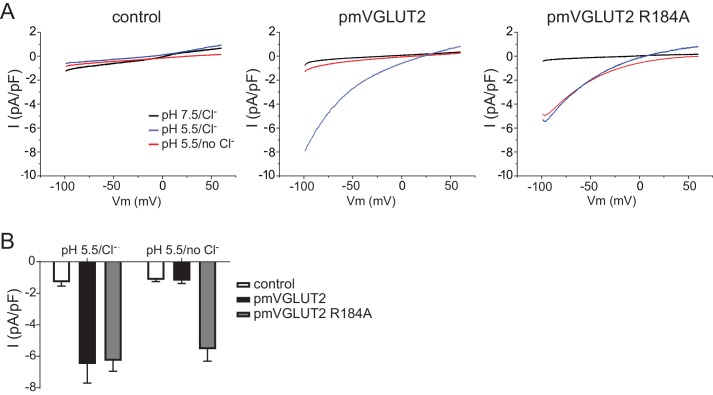
R184A eliminates the requirement for external Cl- to activate the inward Cl- conductance of VGLUT2 misexpressed at the plasma membrane.Whole cell recording of VGLUT2 misexpressed at the plasma membrane (pmVGLUT2) of HEK293T cells. (A) Representative ramp currents from HEK293T cells expressing wild type pmVGLUT2 (left), R184A pmVGLUT2 (middle) or empty vector as negative control (right) in external choline chloride, pH 7.5 (black), choline chloride, pH 5.5 (blue) and choline gluconate, pH 5.5 (red). (B) Maximal inward currents normalized to cell capacitance from voltage ramps of wild type pmVGLUT2 (black), R184A pmVGLUT2 (grey) and vector-only transfected HEK cells (white) in external choline gluconate, pH 5.5 and choline gluconate, pH 5.5. n = 6–9 cells.